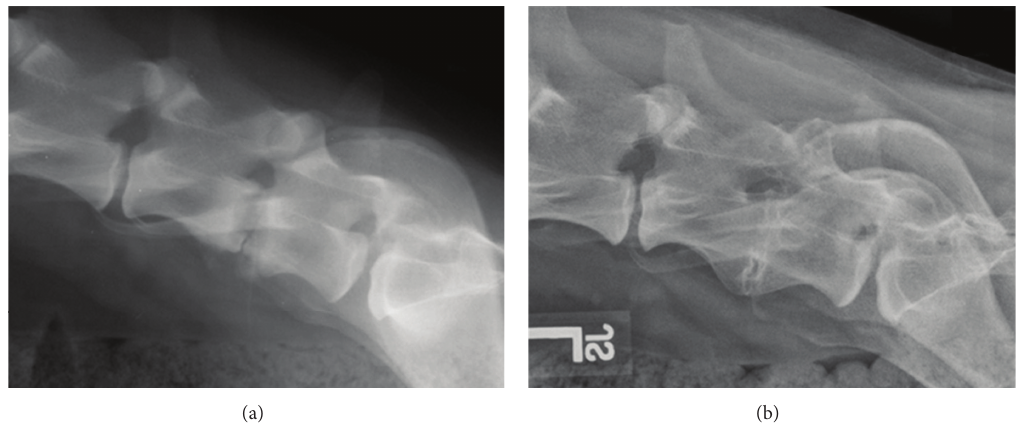
F 1: Lateral radiographs of the lower lumbar spine prior to (a) and aer 8 years (b) of itraconazole treatment. (a) e L6-7 intervertebral disk space is collapsed and there is lysis of the endplates consistent with active diskospondylitis. (b) e L6-7 intervertebral disk space is collapsed and partially fused with smoothly marginated osseous proliferation between the ventral aspects of the vertebral bodies suggestive of healed